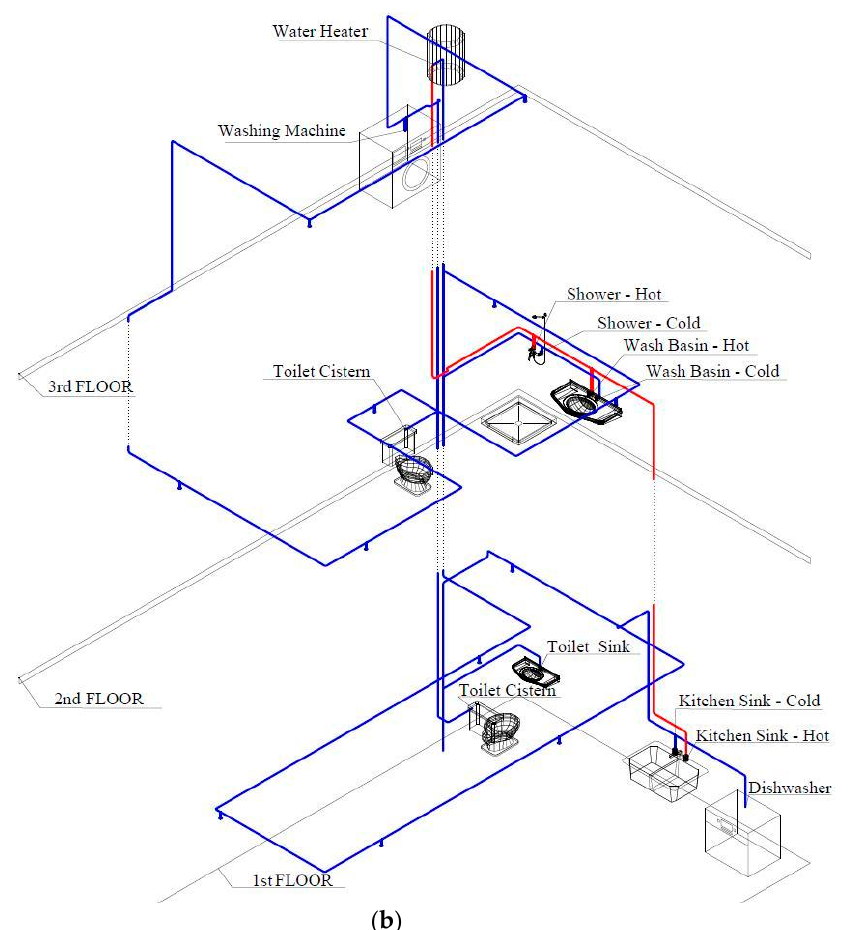
Figure 1. Axonometric scheme of the test rigs: ( a ) Conventional system (CS); ( b ) Extended system